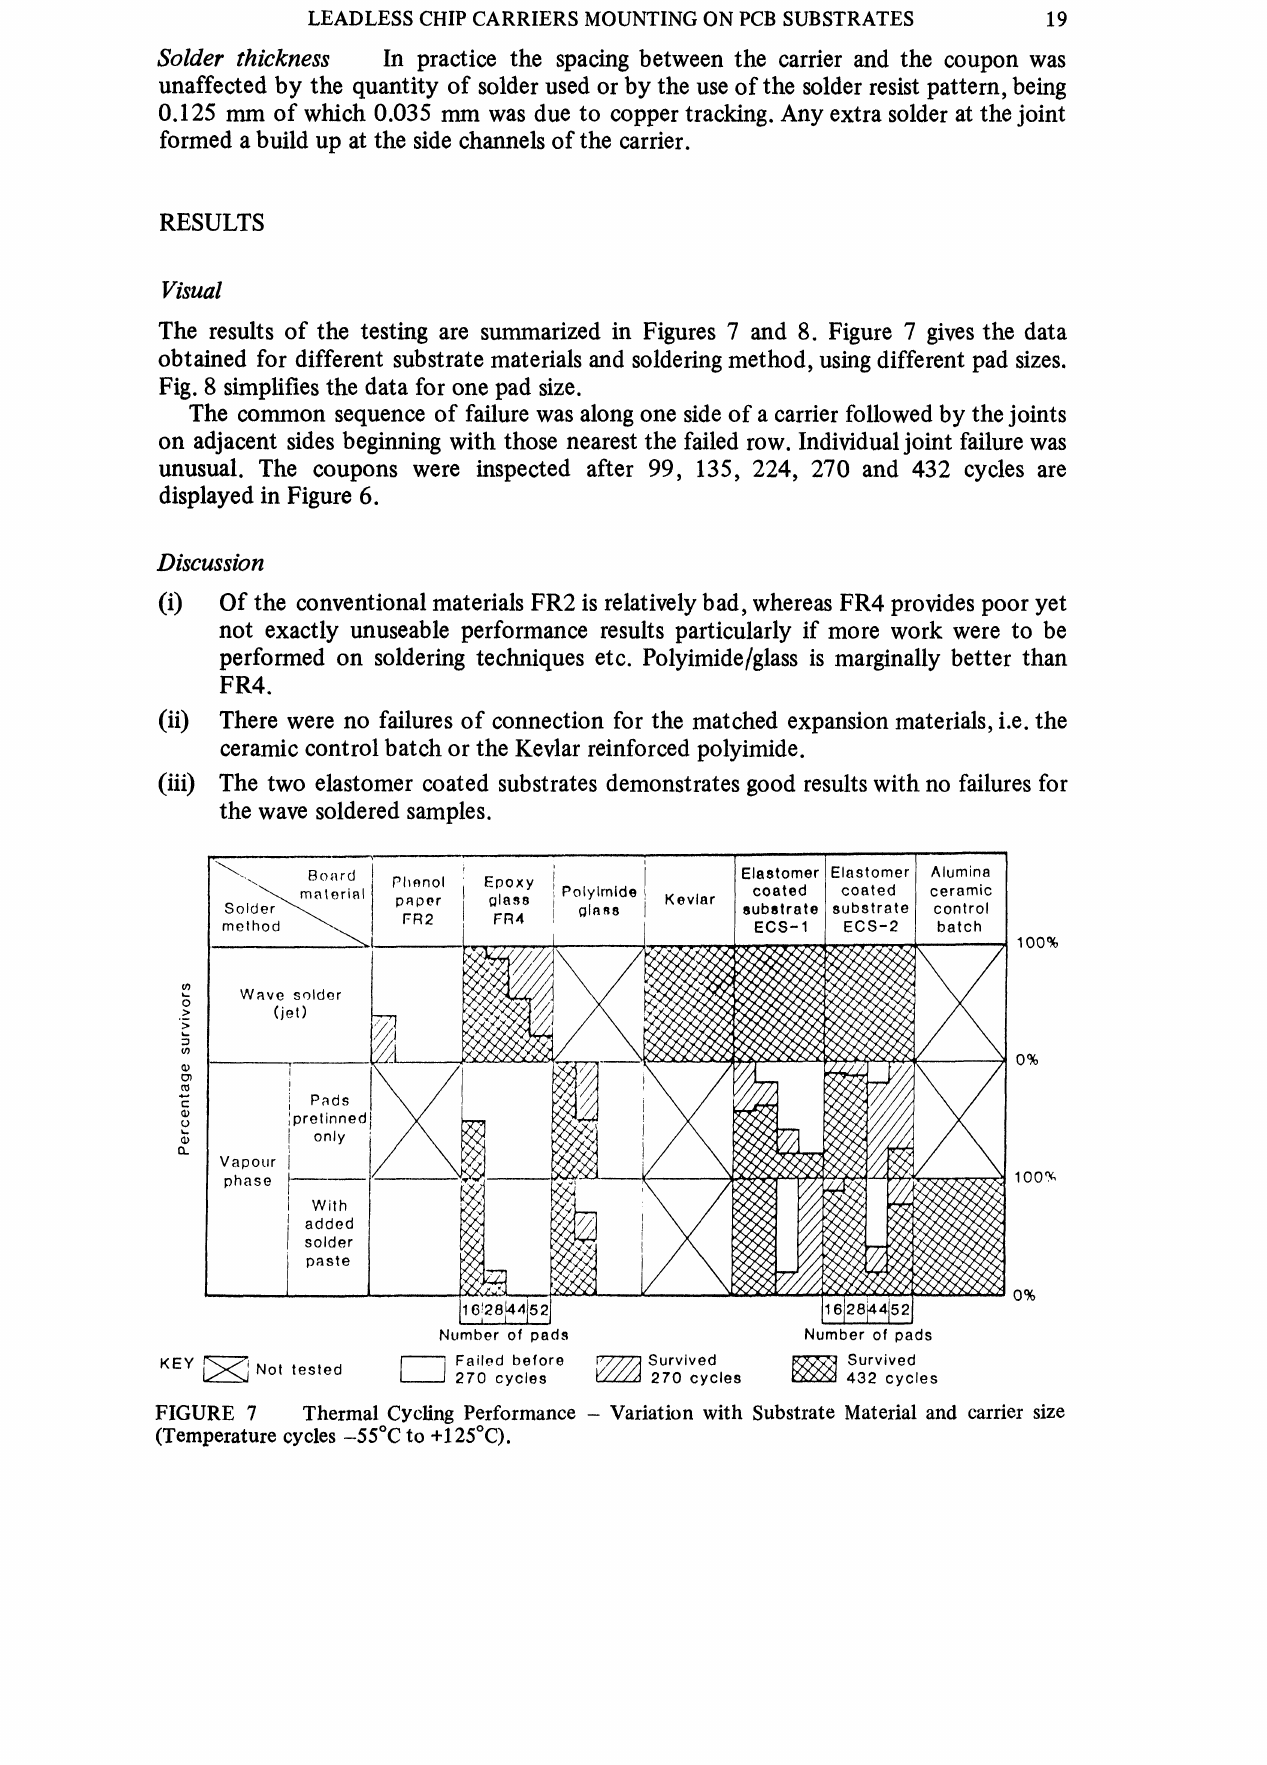
FIGURE 7 Thermal Cycling Performance Variation with Substrate Material and carrier size (Temperature cycles -55C to